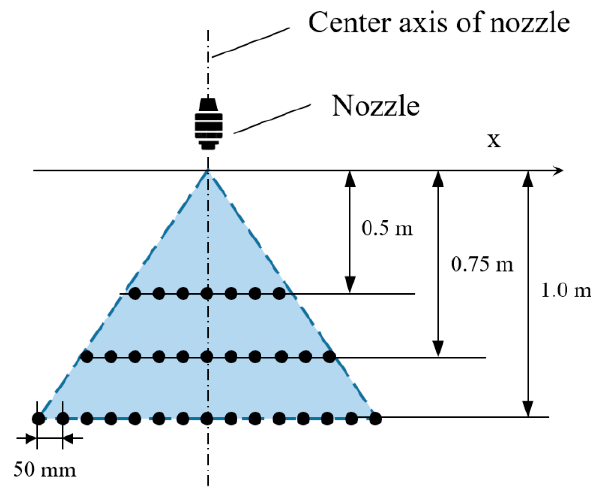
Figure 2. Distribution of particle size test points.